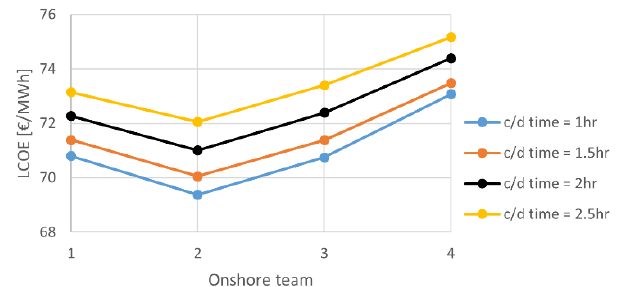
Fig. 29. LCOE versus number of onshore teams (vessels = 2, assembly team = 3).